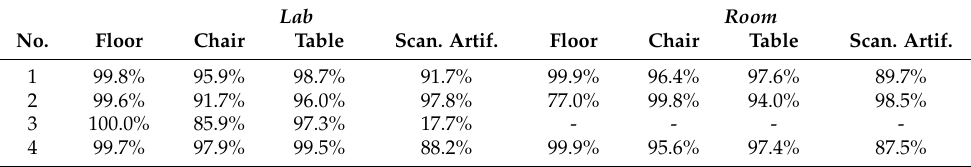
Table A3. Precision for the datasets Lab and Room , semantically segmented by Recap